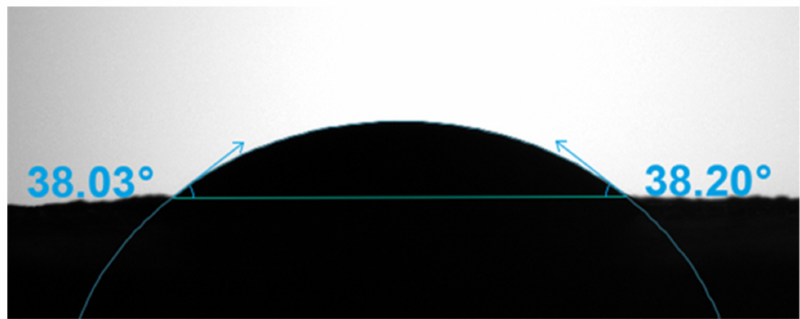
Figure 3. The water-in-air contact angle of the sorghum